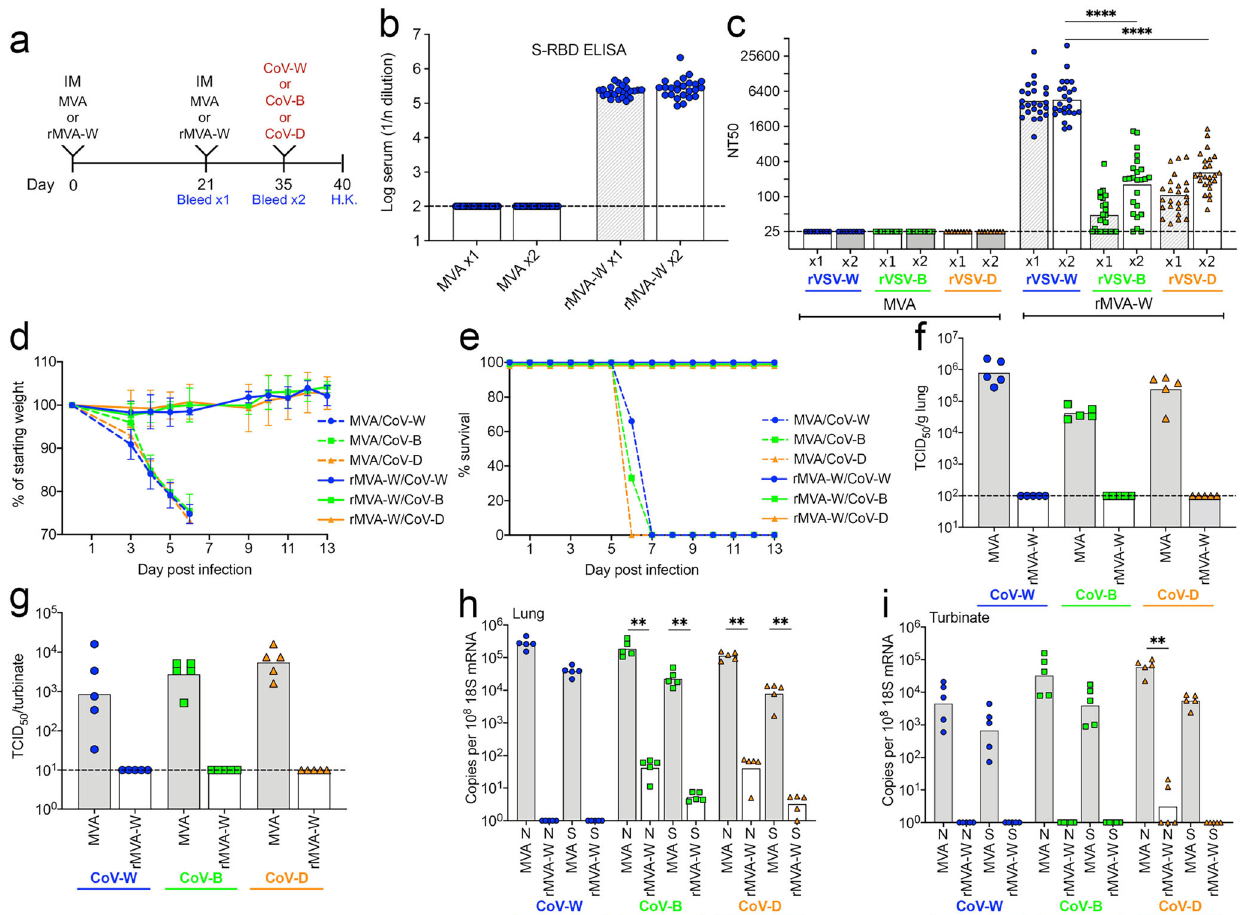
Fig. 1 Protective immunity to SARS-CoV-2 variants following IM vaccination with rMVA-W. a Timeline of K18-hACE2 mice vaccinated IM on days 0 and 21 with 2 × 10 7 PFU of MVA control ( n = 24) or rMVA-W ( n = 24). On day 35, the mice vaccinated with MVA and rMVA-W were each divided into 3 groups of n = 8 and each group was challenged with 10 4 TCID 50 of CoV-W, -B, or -D and 5 mice from each group were humanely killed 5 days later. The remaining 3 mice from each group were followed for weight loss and morbidity. b Serum antibody binding to the Wuhan S RBD and c neutralization of pseudoviruses rVSV-W, -B and -D at 3 and 5 weeks after vaccination were carried out with all MVA vaccinated mice ( n = 24) and all rMVA-W vaccinated mice ( n = 24). d Time course of weight loss and e survival on days after challenge with CoV-W, CoV-B or CoV-D were determined for 3 mice from each challenge group. Recovery of SARS-CoV-2 from f lungs and g nasal turbinates on day 5 after challenge of 5 mice from each challenge group. Copies of sgRNAs N and S relative to 18 S RNA from h lungs and i nasal turbinates on day 5 of the same mice analyzed in f and g . D day, HK humanely killed. Statistics: for c one way ANOVA with Tukey post-hoc test; for panels H, I Mann-Whitney. Error bars, SD; ** p ≤ 0.002; **** p < 0.0001. Signi fi cance was not calculated when values of one group were all below the limit of detection. Dotted line, limit of